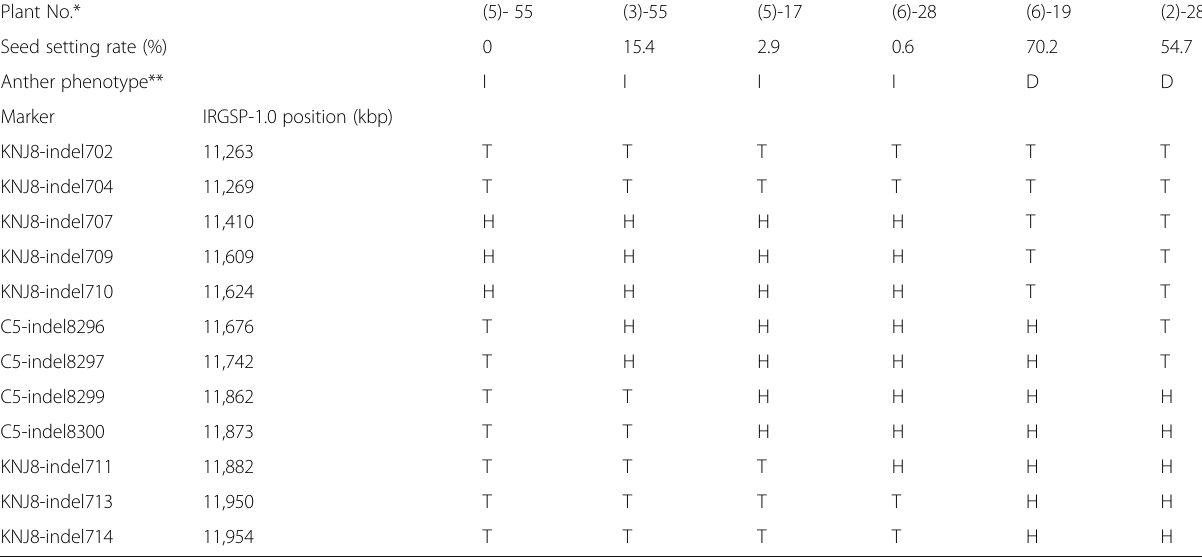
Table 1 Chromosomal position of markers, and genotypes, anther phenotypes, and seed setting rates in BC 6 F 1 recombinant plants Plant